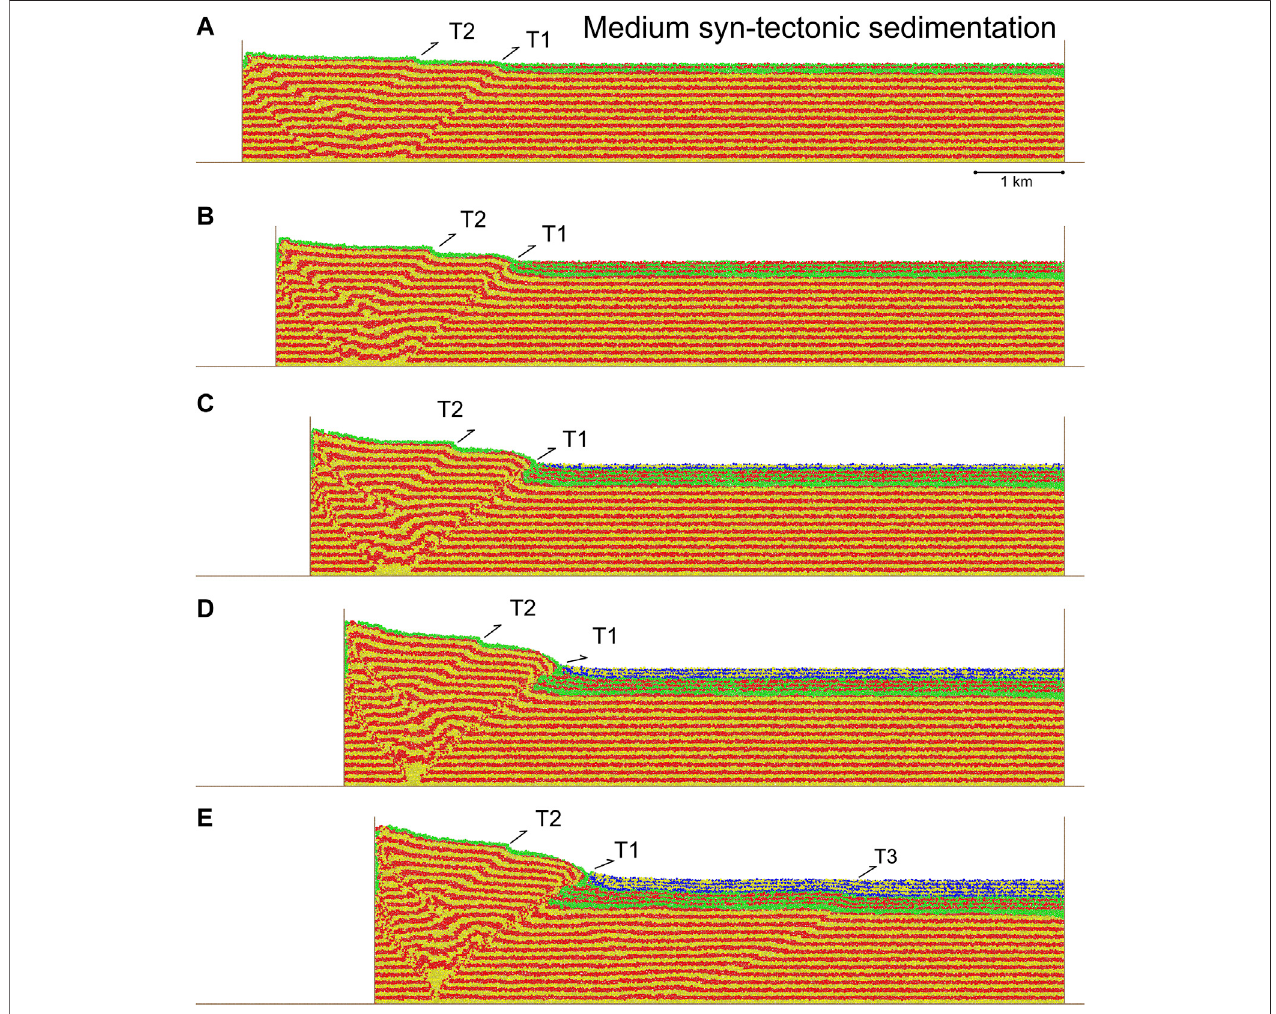
FIGURE4| Experiment3,progressiveevolutionofacontractionalmodelwith “ medium ” syn-tectonicsedimentation.Resultsareshownafter500(4%),1,000(8%), 1,500 (12%), 2000 (16%), and 2,500 (20%) m contraction/displacement on the left-hand end-wall. Two distinct growth packages are highlighted/coloured in order to show the stratal architectures developed inearly (green-red package) and mid/late (blue-yellow package) fault array growth, the transition occurringat c. 1,250(10%) m of lateral contraction, see text for discussion.